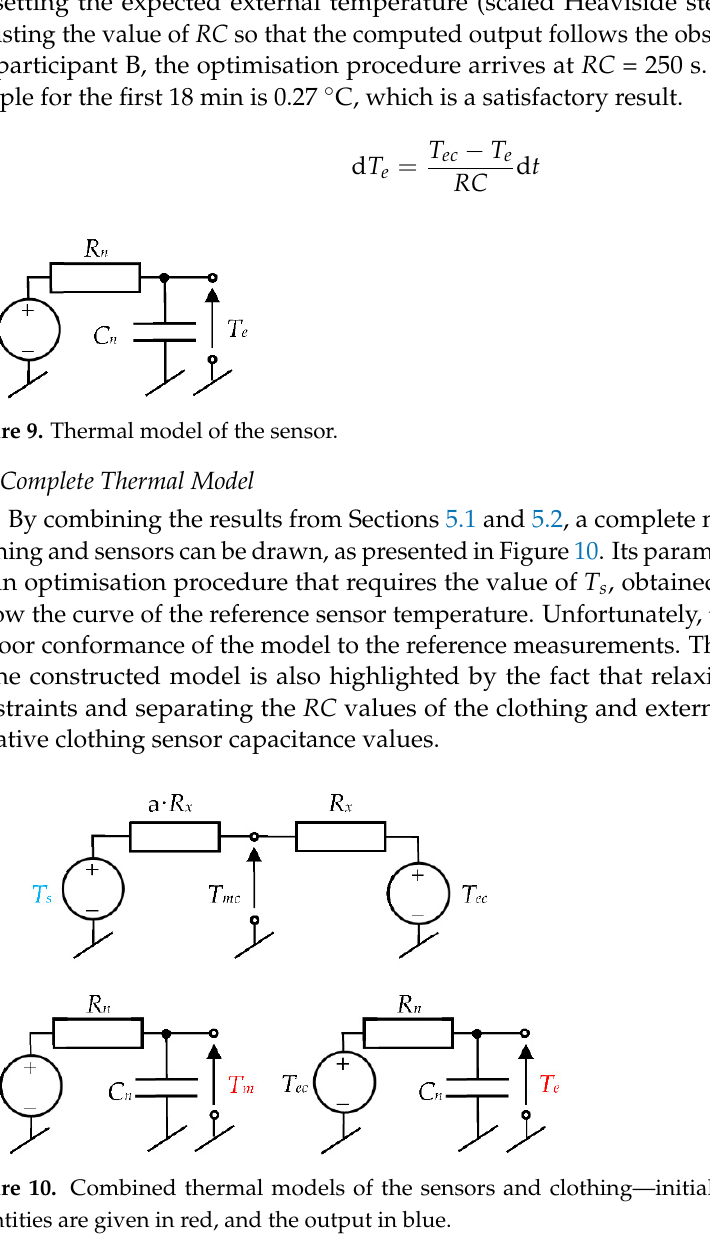
Figure 11. Final thermal models of the sensors and clothing. The input quantities are given in red, and the output in blue.